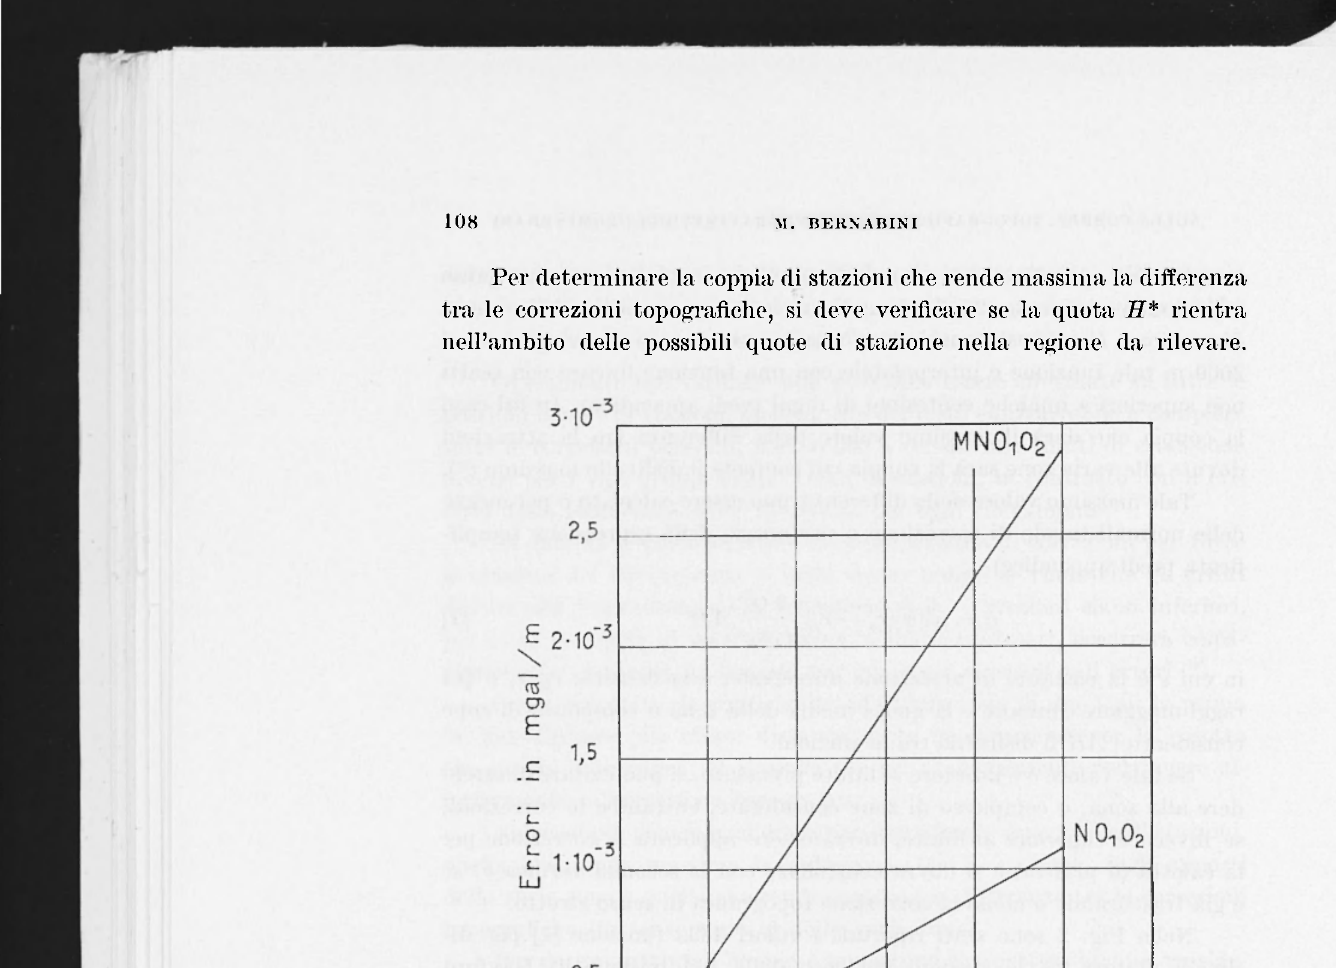
Fig. 2 - Errori per unità di differenza di quota tra due stazioni, dovuti al trascurare completamente le zone di Hayford indicate al fianco dei